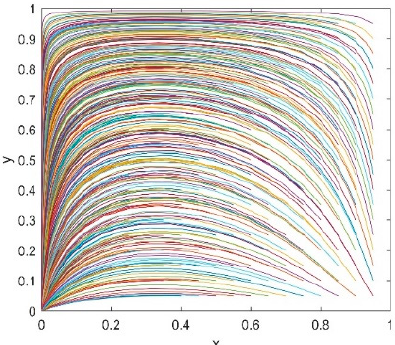
Figure 11. Evolution of the integrated strategy in Case 3.